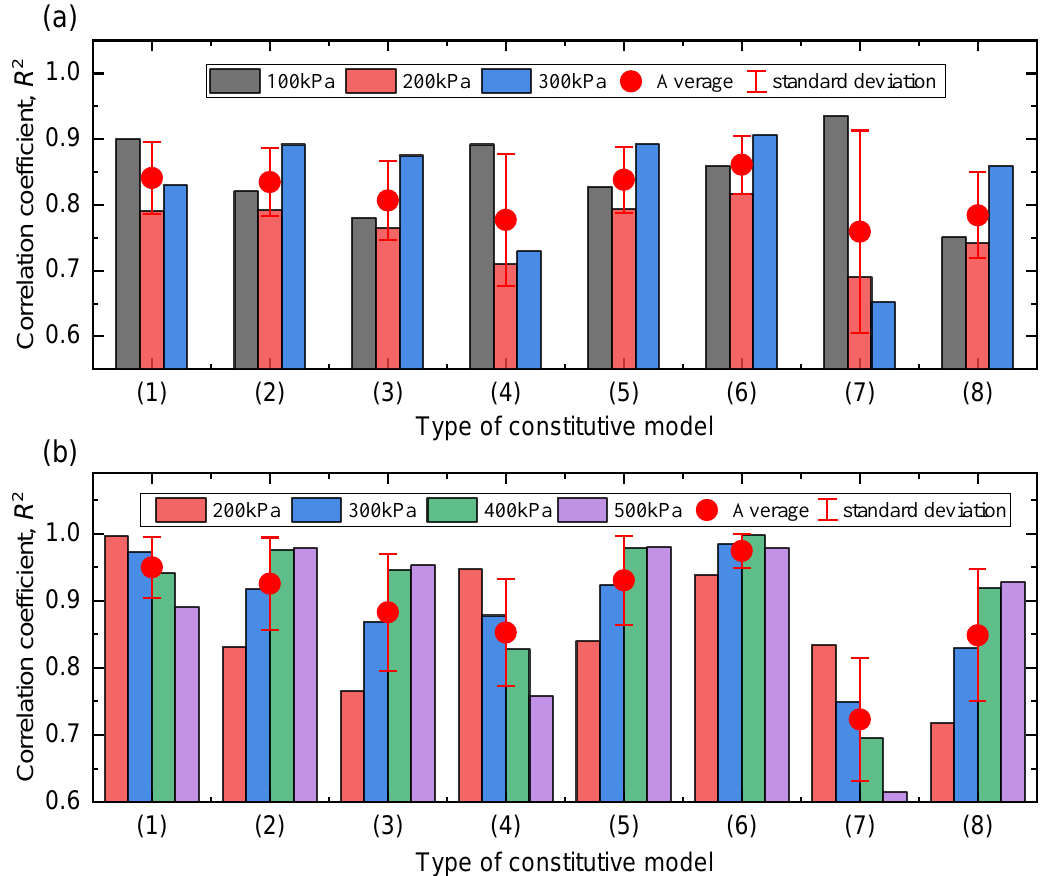
Figure 11. Correlation coefficient analysis of shear constitutive models. ( a , b ) Present the correlation coefficients of various shear constitutive models based on different distribution functions for Huangtupo landslide slip zone soil representing weak softening type, and for Shizibao landslide slip zone soil representing strong softening type, respectively. (1) Weibull-constitutive model; (2) logistic-constitutive model; (3) normal-constitutive model; (4) lognormal-constitutive model; (5) exponential-constitutive model; (6) Gamma-constitutive model; (7) hyperbolic-constitutive model; (8) Gumbel-constitutive model.